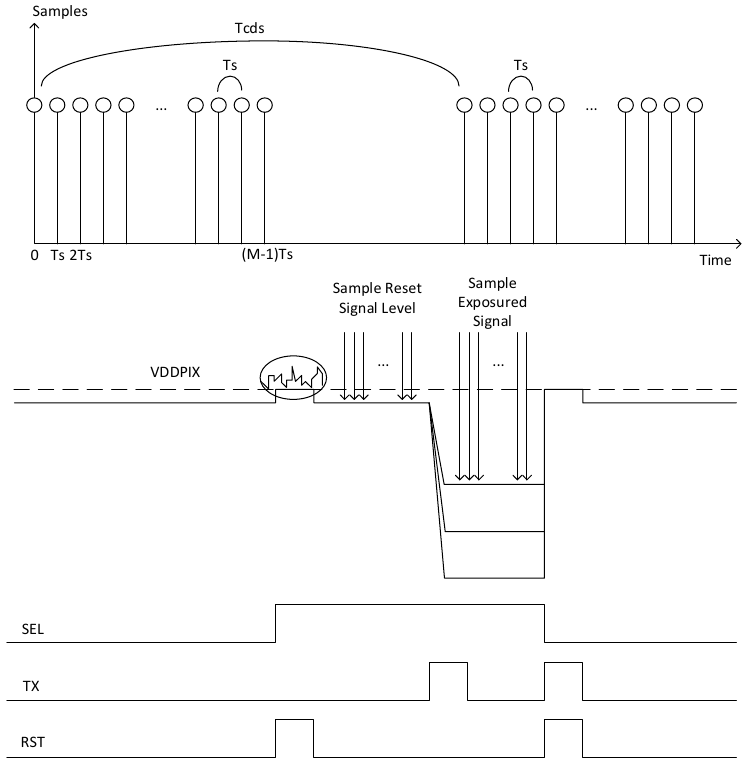
Figure 1. Simplified 4T-pinned pixel correlated multiple sampling (CMS) sampling operation. ( top ) The CMS process from signal processing perspective; ( bottom ) equivalent time domain pixel readout signals and corresponding pixel timing control signals.